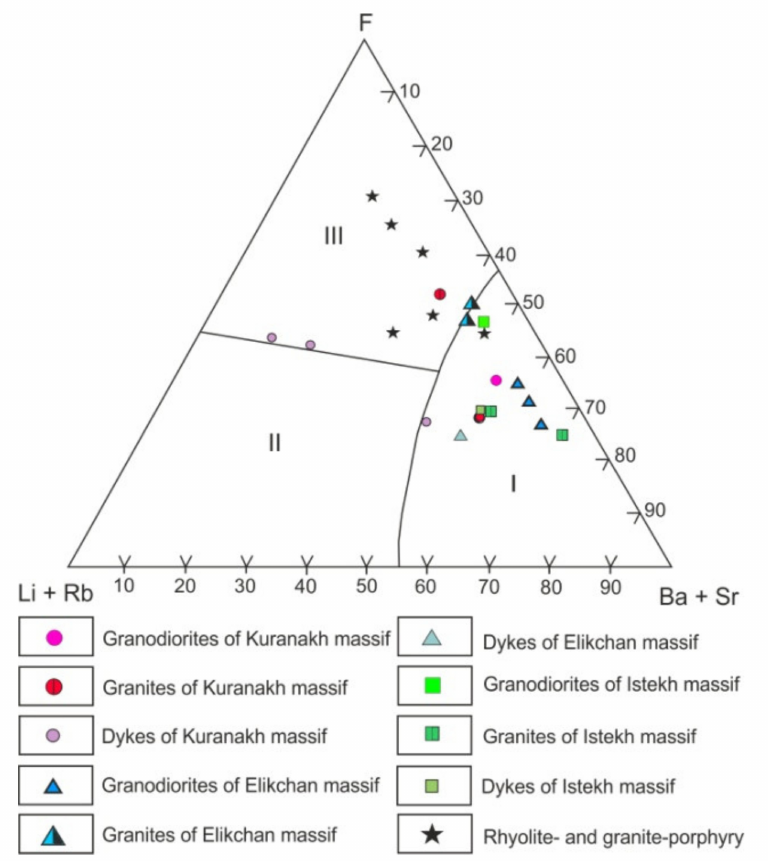
Figure 14. (Li + Rb)–F–(Ba + Sr) diagram for granitoids. Fields on the diagram are derived from [94]: I—barren; II—weakly mineralized; and III—highly mineralized